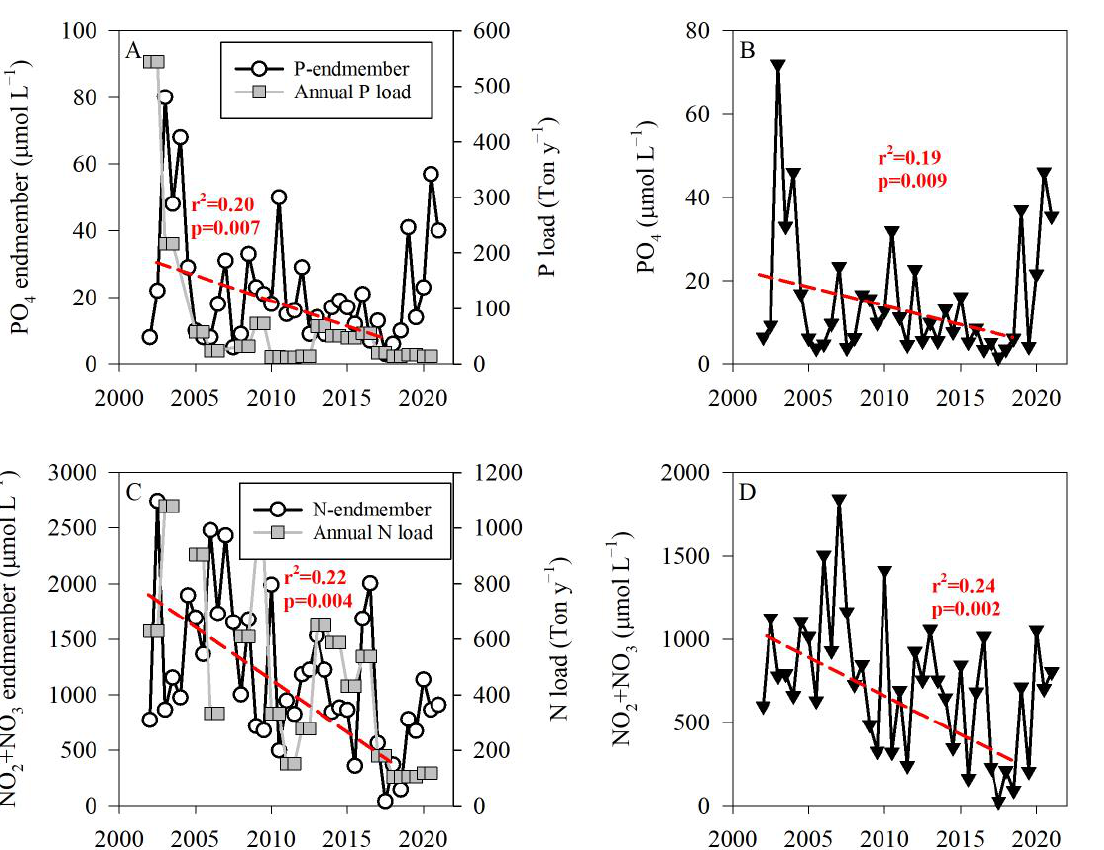
Figure 4. Time series of the calculated anthropogenic freshwater nutrient endmembers using equa- tion 3 ( A , C , E, circles) and the time series of the measured nutrient concentrations at the surface water of the Histadrut station ( B , D , F, triangles). Data are shown for PO 43 − ( A , B ), NO 2 − + NO 3 − ( C , D ), and NH 4+ ( E , F ). The total N and P loads into the Kishon river from anthropogenic point sources are presented as well (source: Israel Ministry of Environmental Protection, 2021 Report on pollutants budget; www.gov.il/he/departments/guides/kishon_stream_point_pollution_loads?chapterIn- dex=5, accessed December 2022). The loads were calculated using the annual cumulative effluent discharge per point source multiplied by the annual average N and P concentrations. Note the dif- ferent Y axis. The red lines show the linear decreasing trends for the period 2002 – 2018.